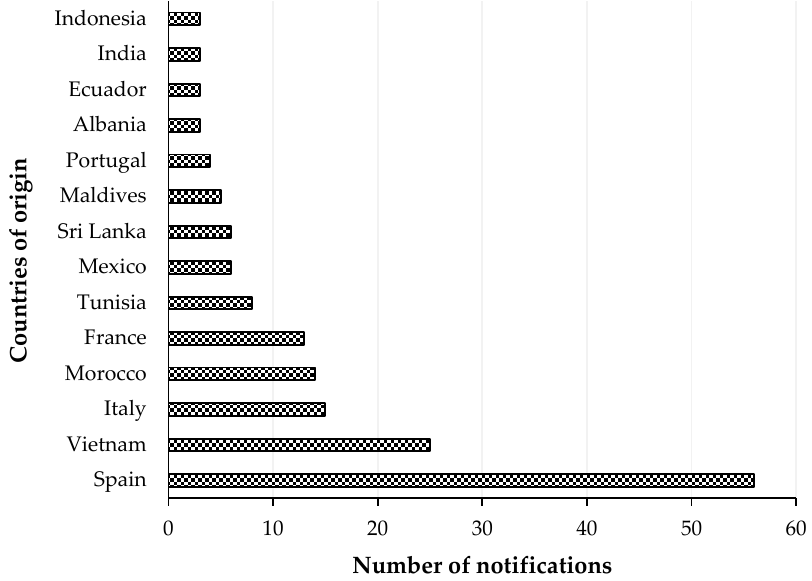
Figure 1. List of notifying countries and number of notifications for histamine presence in “fish and fish products” by the Rapid Alert System for Food and Feed (RASFF) from 1 January 2015 to 31 August 2020.